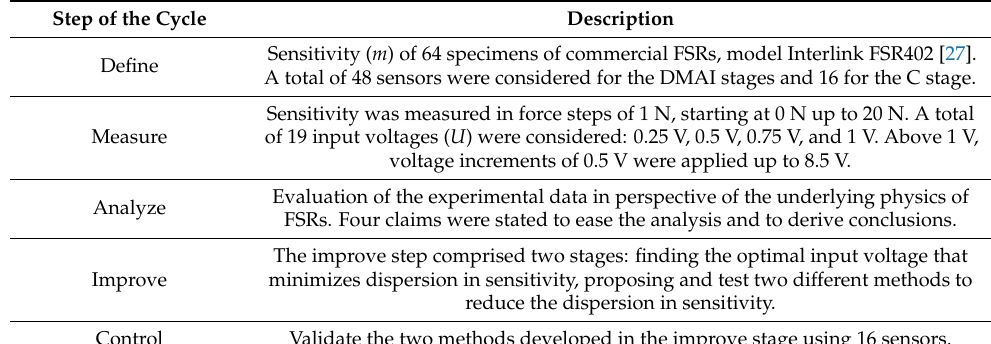
Table 1. Summary of the DMAIC cycle with a brief description of each